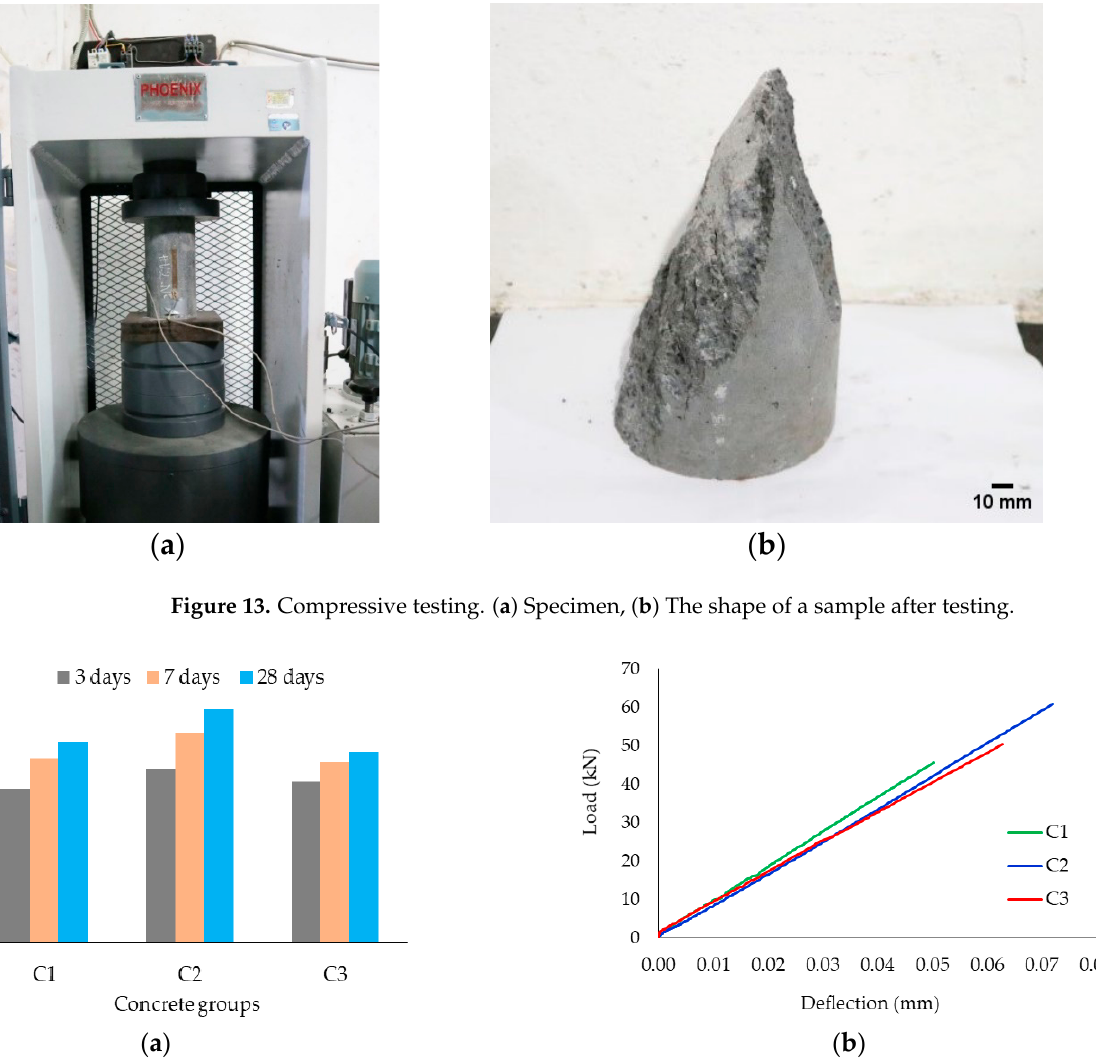
Figure 14. Experimental results. ( a ) Compressive strength, ( b ) Load capacity of the flexural test.